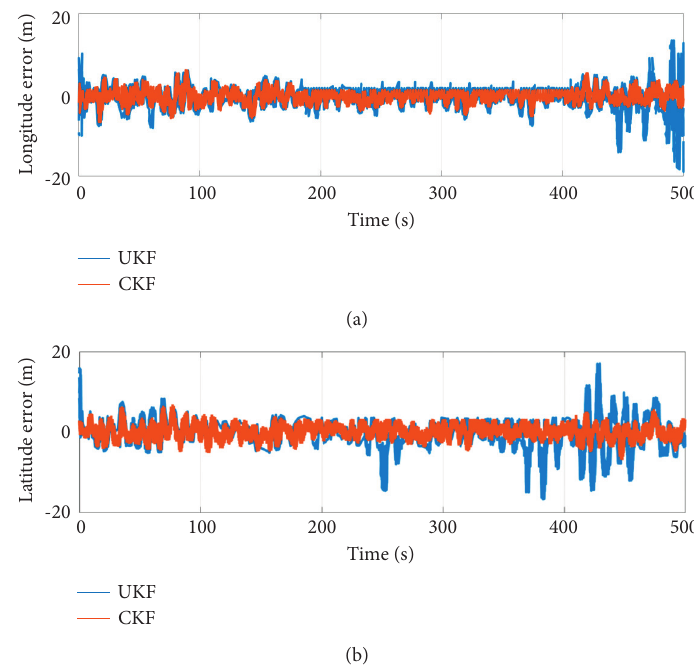
Figure 3: Estimation error of latitude and longitude.